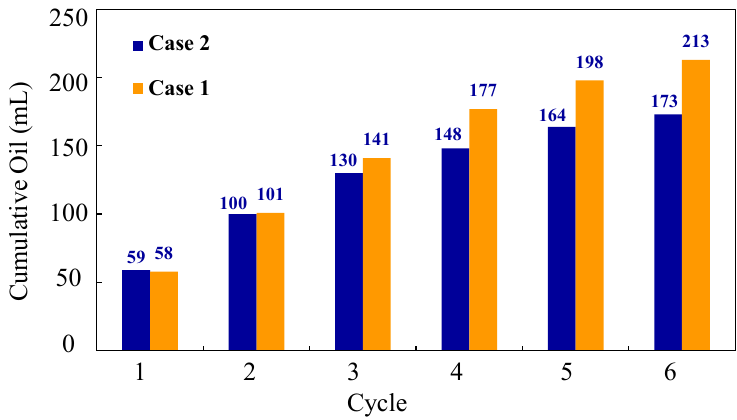
Figure 9. Cumulative oil production of case one and case two.